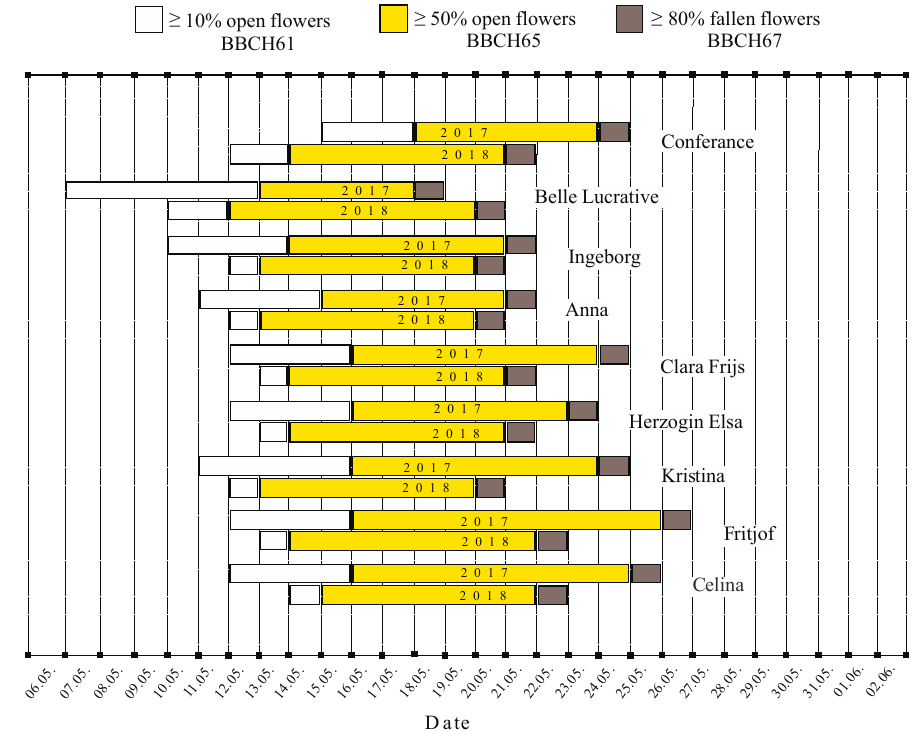
Figure 2. Flowering phenophases of all studied pear cultivars in 2017 and 2018.